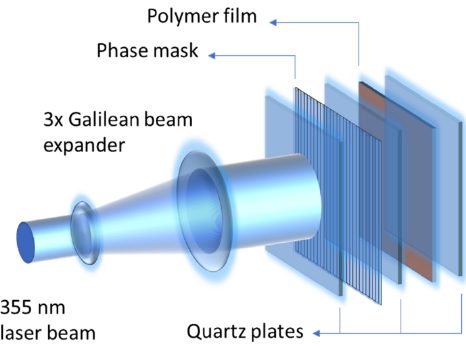
Figure 1. Laser irradiation sketch used for permanent relief grating generation on sample